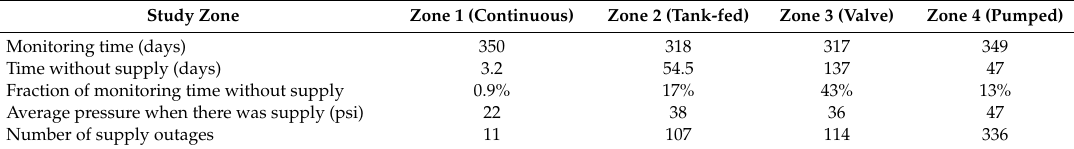
Table 3. Summary statistics of supply in each zone. Supply was considered to be o ff in Zones 1–3 when the pressure at the downstream station was < 2 psi at ground level. Zone 4 was considered to be without supply when the pump station serving the zone was o ff . Average pressure for all zones is at the downstream monitoring